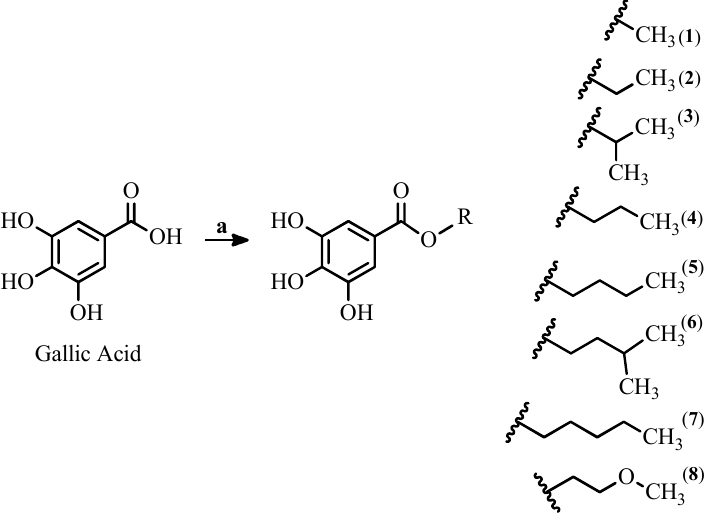
Figure 1. Procedure for preparing gallic acid alkyl esters. Reagents and conditions: (a) ROH, H 2 SO 4 (cat.), reflux, 3–7 h.